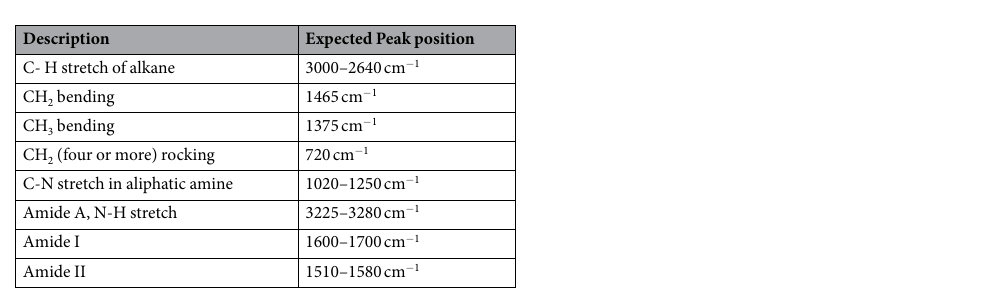
Table 1. Expected IR peak positions pertaining to the secondary structure of proteins.